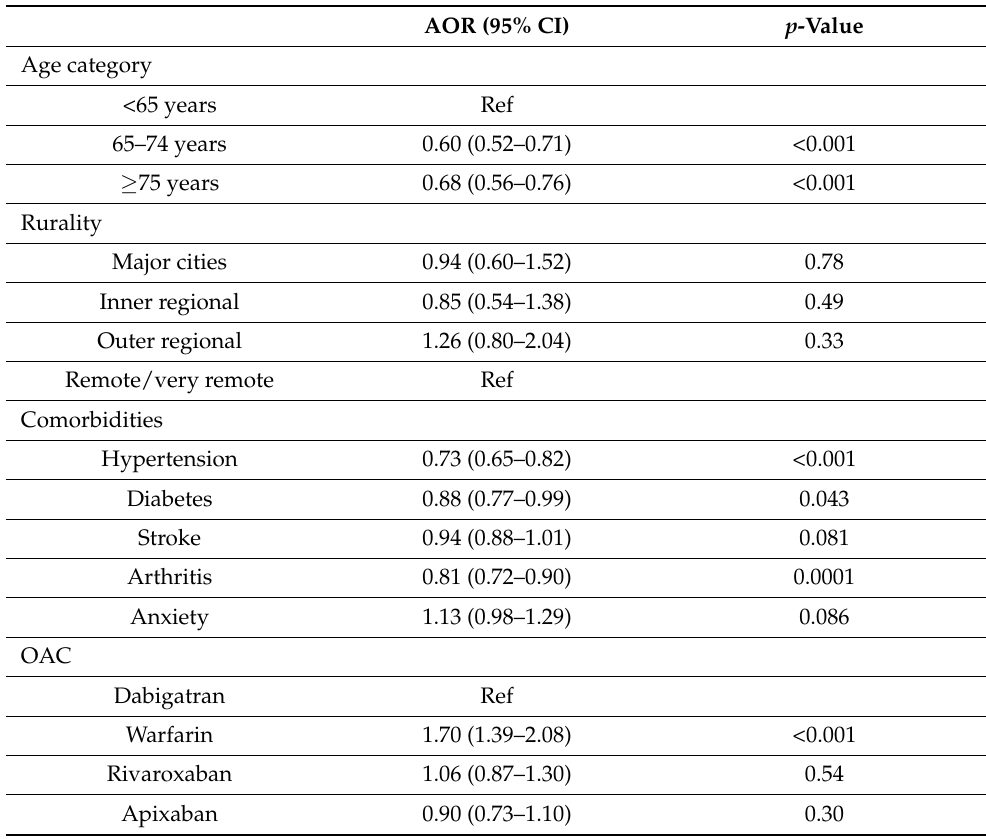
Table 2. Factors associated with discontinuation of